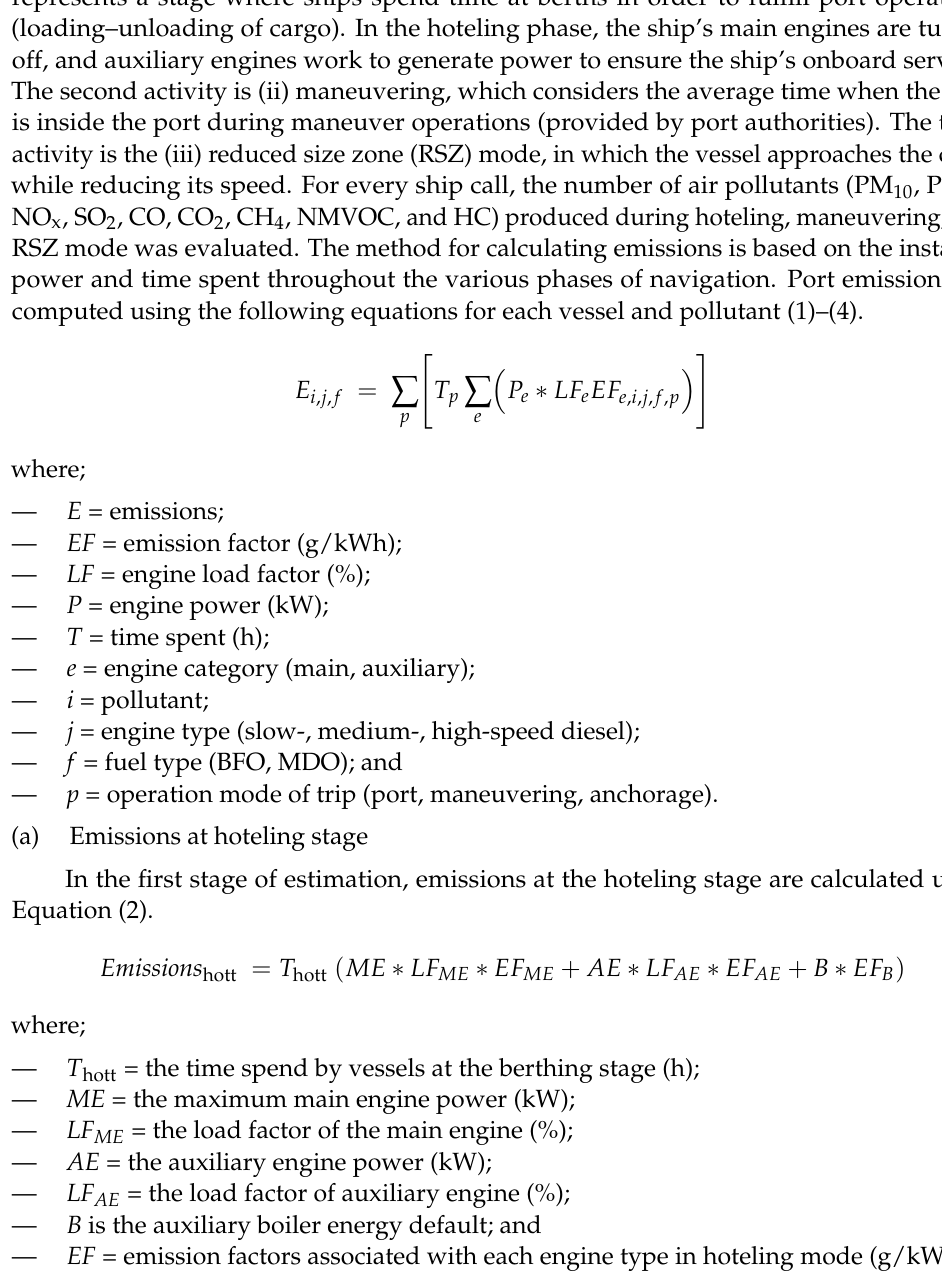
Emissions at maneuvering